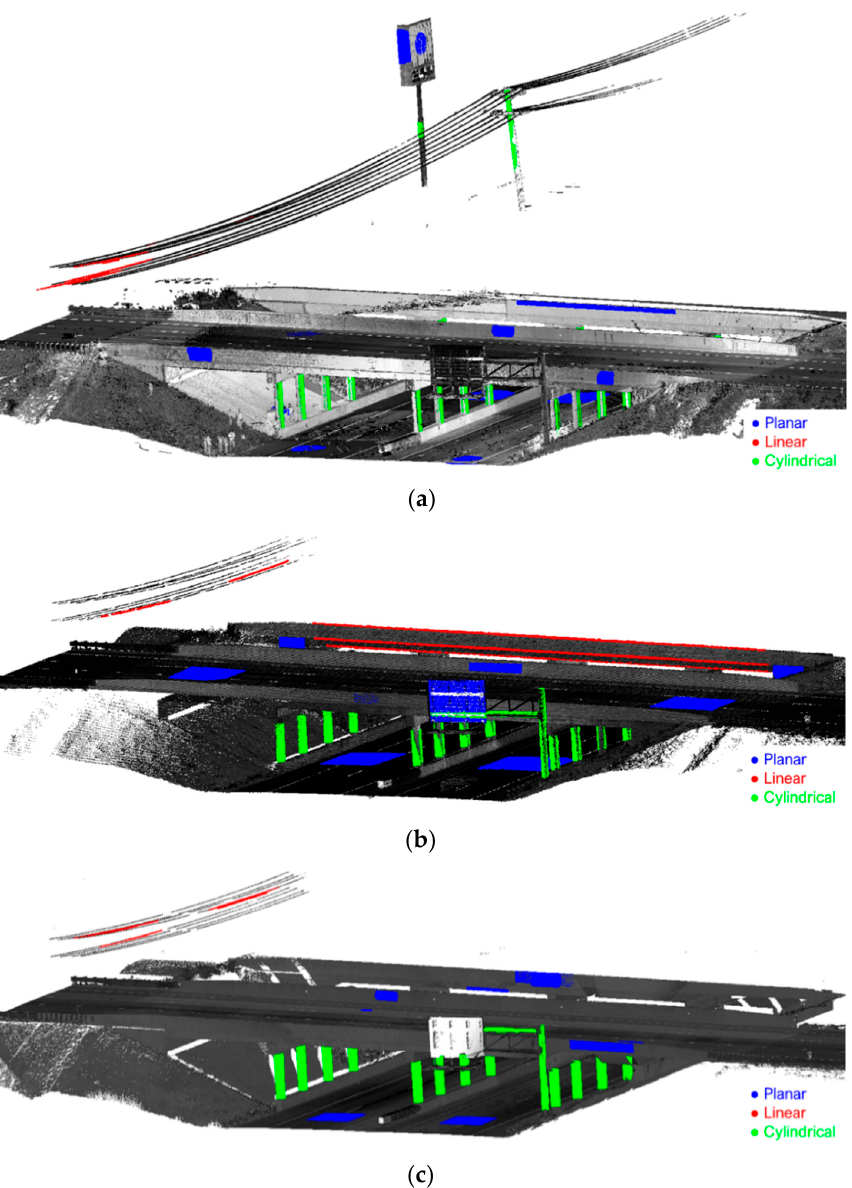
Figure 14. Extracted planar/linear/cylindrical features (in blue/red/green, respectively) for the registration of ( a ) TLS, ( b ) PWMMS-HA, and ( c ) PWMMS-UHA point clouds.